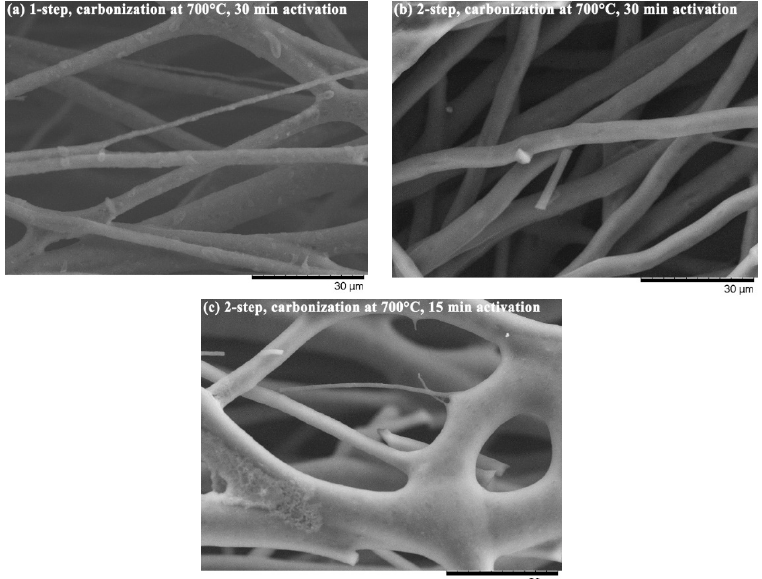
Figure 3. LACFs from different treatment conditions. ( a ) carbonization at 700 °C through one-step activation with activation time of 30 min; ( b ) carbonization at 700 °C through two-step activation with activation time of 30 min; ( c ) carbonization at 700 °C through two-step activation with activation time of 15 min.